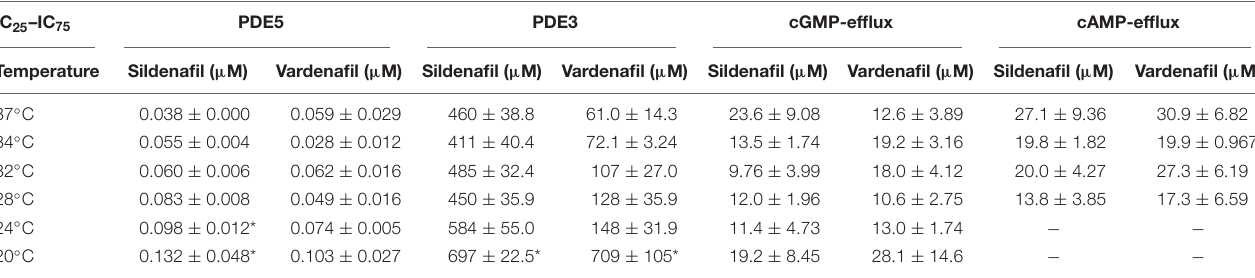
TABLE 6 | IC 25 –IC 75 intervals, describing the concentration needed to increase inhibition of phosphodiesterase-5 (PDE5), phosphodiesterase-3 (PDE3), and inhibition of cAMP- and cGMP-efflux from 25% to 75%, at temperatures ranging from 37 ◦ C to 20 ◦